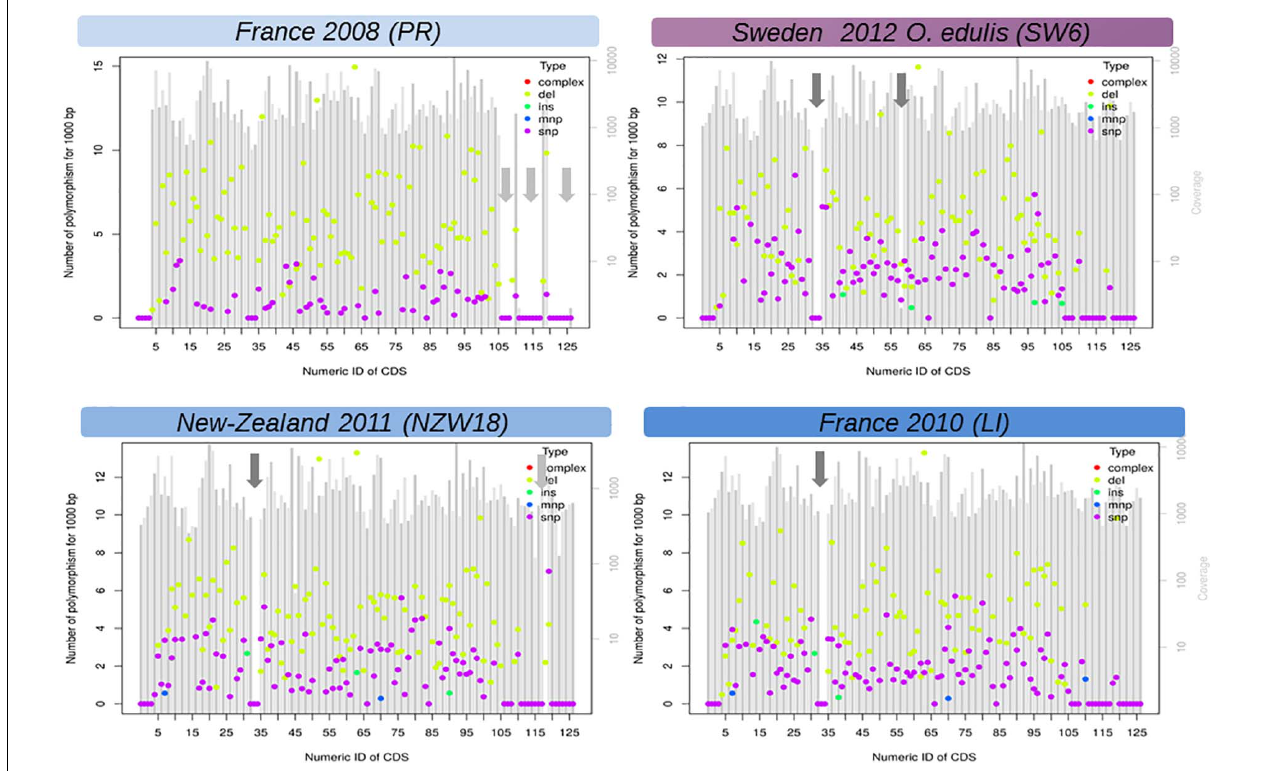
FIGURE 3 | Functional view of DNA variation (mutations) density along the genome of Ostreid herpesvirus 1 (OsHV-1). Here only LI, PR, NZ17, and SW6 are shown. The X-axis is the number of CDS found in the reference annotation genome last accessed (Davison et al., 2005) and the Y-axis is a standardized count of mutations found in 1,000 bp if the SNP density where the same in the targeted CDS. Genomic regions with a low complexity content (repeated sequences) were not considered in this analysis (light gray arrows). SNP, single nucleotide polymorphism; INS, short insertion ( < 50 bp); DEL, short insertion ( < 50 bp); MNP, short complex polymorphism, dark gray arrows: large deletion ( > 50 bp). Figures of all samples (detailed Table 1 ) are given in Supplementary Files